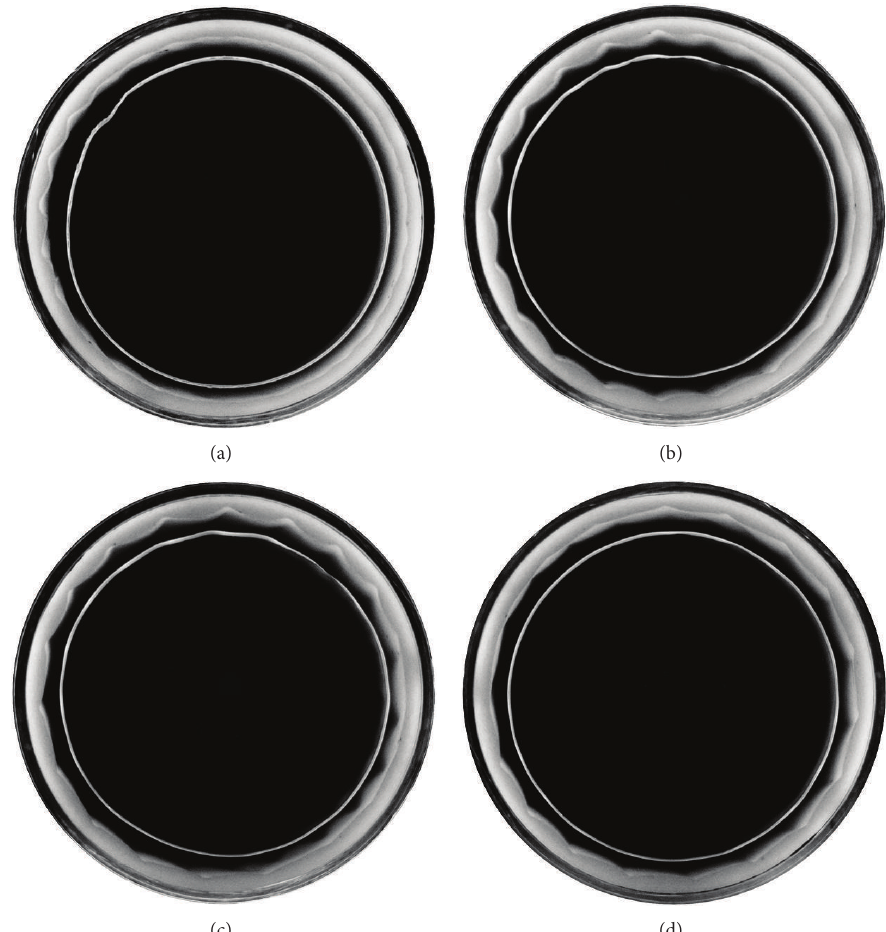
Figure 3: Time evolution of squashed ripples: 𝑡 = 2, 7,12 and 50 min ((a)–(d)); Ω = 35.6 s −1 , ] = 1.4 cSt, 𝑞 = 0.215 , and 𝑚 = 250 g.